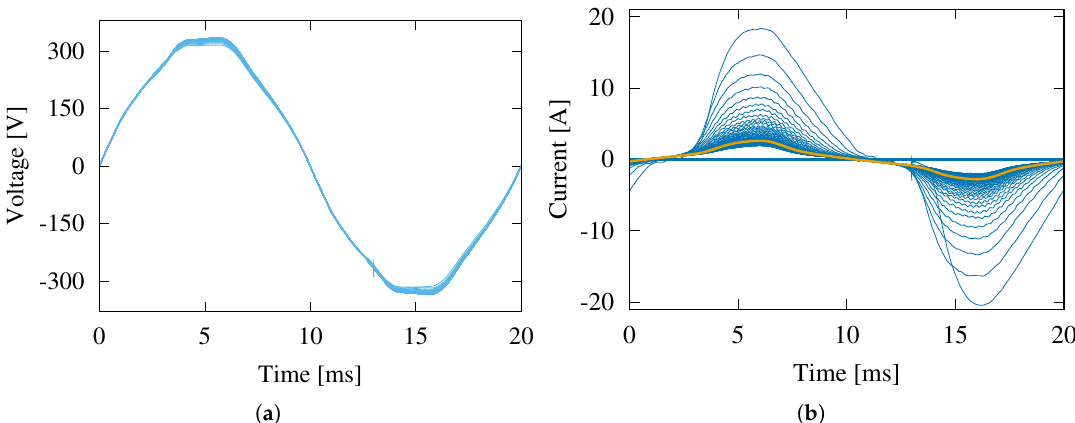
Figure 2. Superposition of voltage and current waveforms during the appliance activity. The current waveform crosses the zero value slightly after the voltage’s zero-crossings, indicating a phase shift. ( a )Voltage waveforms; ( b ) Current